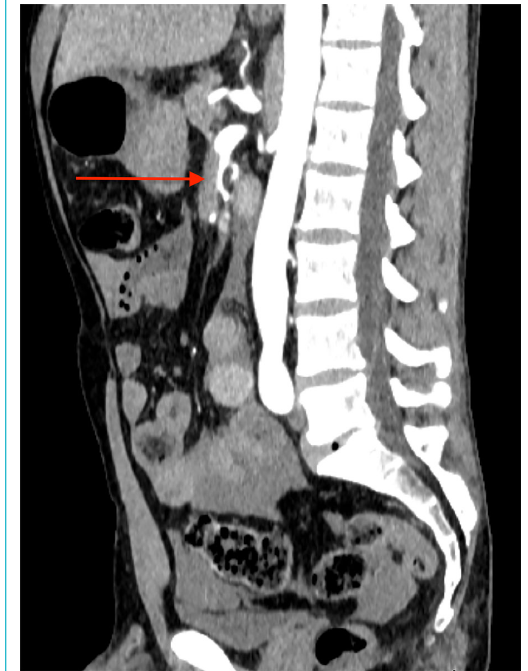
Figure 2: Emergency abdominal CT scan showing dissection of the superior mesenteric artery